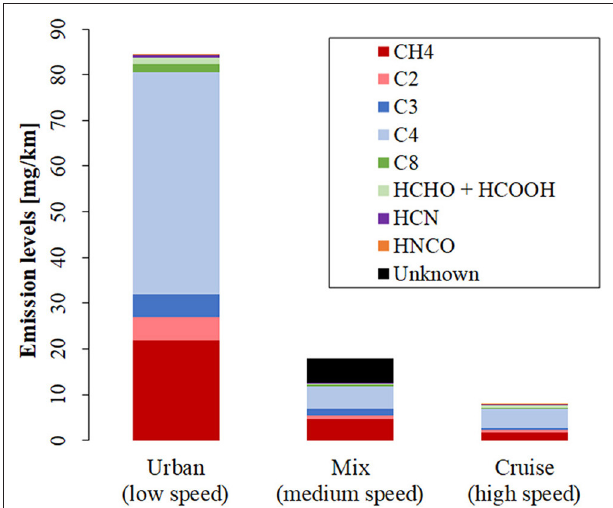
FIGURE 11 | Emission level for the FTIR gas analyser recorded HC species: Methane, C2 (Acetylene, Ethylene, Ethane), C3 (Propylene, Propane), C4 (Butane, Butadiene), C8 (Octane), Formaldehyde and Methanoic Acid, Hydrogen Cyanide, Isocyanic Acid, unknown species.